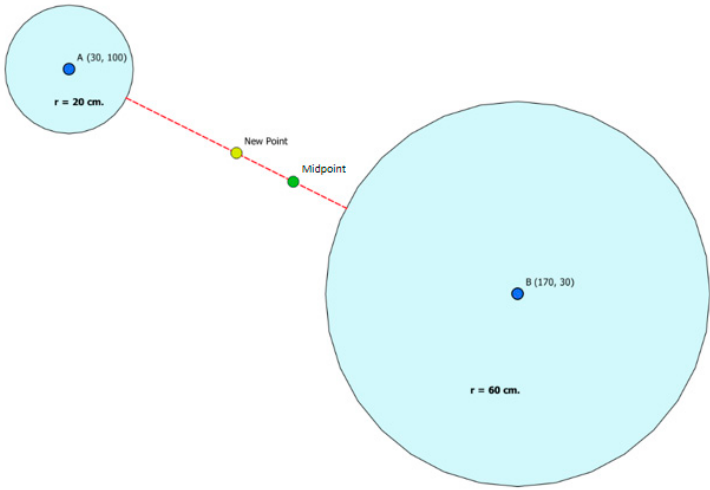
Figure 12. Weighted symmetric point between points A and B.